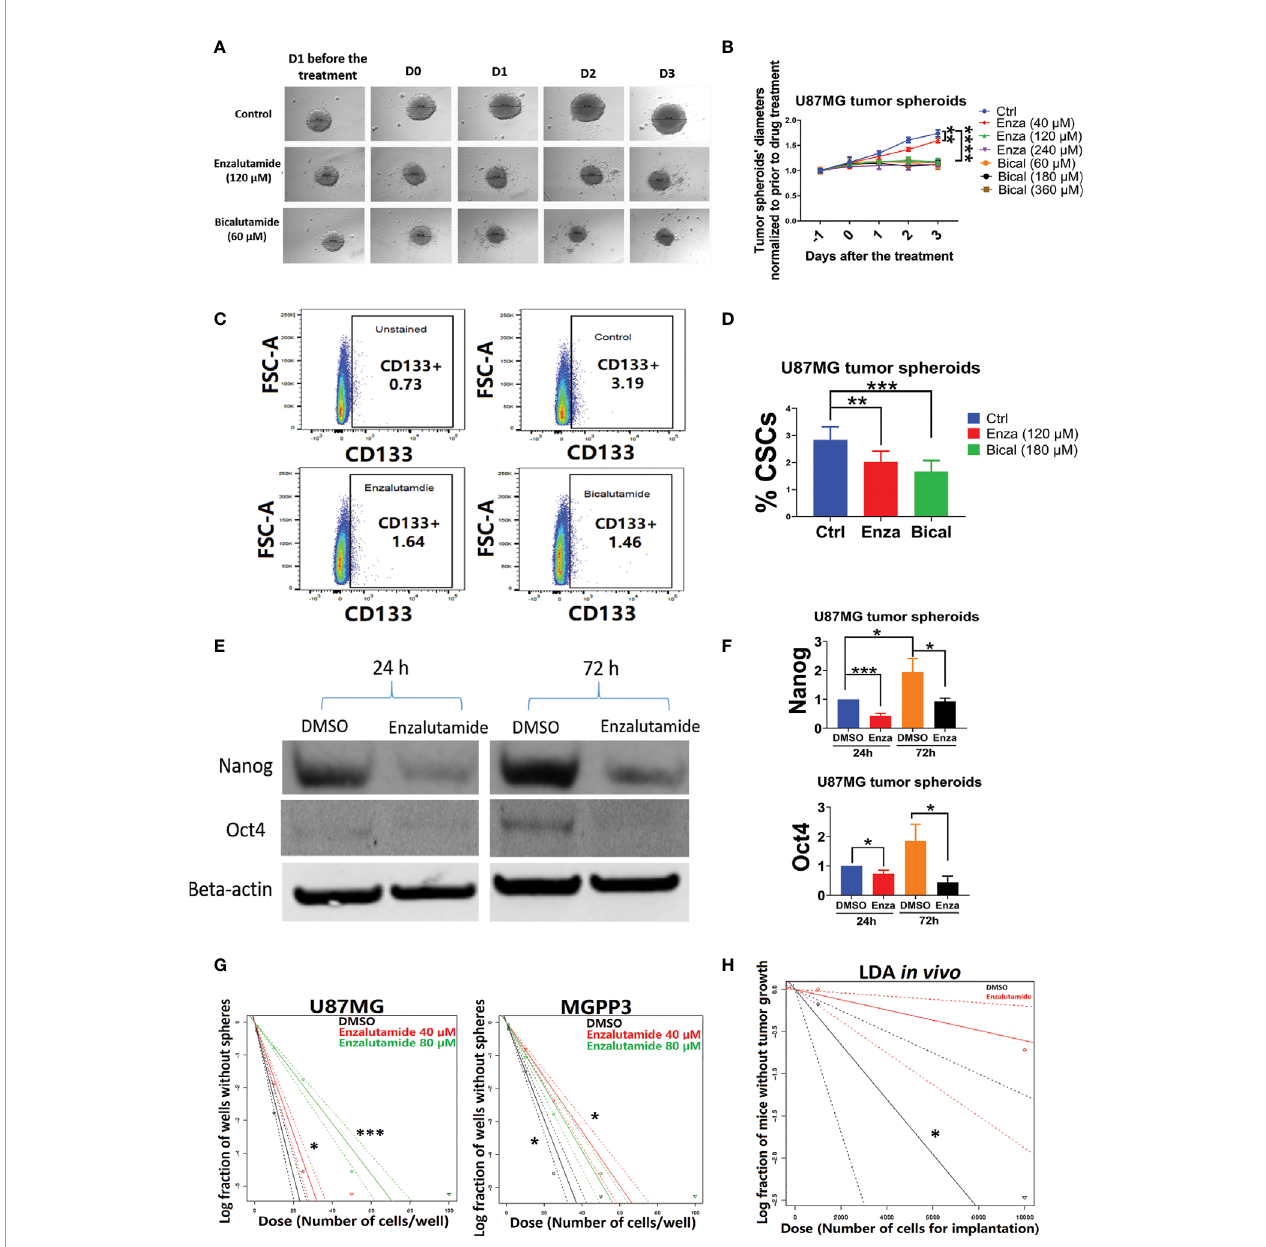
FIGURE 4 | AR antagonists decrease the cancer stem cell population in U87MG GBM cells in vitro . U87MG spheroids were cultured in low serum medium (0.5%) for 2 days and then treated with DMSO (negative control), enzalutamide (120 µM), or bicalutamide (180 µM) for another 4 days with diameters of spheroids measured daily. (A) Representative fi gures of the U87MG spheroids before and after the treatment of enzalutamide (120 µM) or bicalutamide (60 µM). (B) Measured diameters of the spheroids normalized to before the treatment during drug treatment with increasing concentrations of enzalutamide (40, 120, and 240 µM) or bicalutamide (60, 180, and 360 µM). (C) Representative fl ow cytometry gating strategy with dissociated cells from U87MG spheroids. Upper left: no drug treatment and no CD133 antibody staining; upper right: DMSO only (no drug treatment control); lower left: enzalutamide (120 µM); lower right: bicalutamide (180 µM). (D) CSC populations (CD133+) were compared in dissociated cells from spheroids with or without treatment of AR antagonists using fl ow cytometry as shown in (C) Eight replicates per group were used for fl ow cytometry with mean values presented in the histogram. (E) Western blotting assays showed decreased expression levels of CSC markers, Nanog and Oct4, after enzalutamide treatment for 24 and 72 h. (F) Quanti fi cation of Nanog and Oct4 protein levels before and after the treatment of enzalutamide for 24 and 72 h. All experiments were performed with three independent replicates. (G) Extreme Limiting Dilution Assays (ELDA) in vitro to estimate the frequency of tumor sphere-forming stem-like cells in U87MG and MGPP3 cell lines. Plot of the log (e) fraction of wells without tumor spheres as a function of plated U87MG/MGPP3 cell number/well. The more vertical the line, the higher the percentage of tumor sphere-forming cells or CSCs. (H) Extreme Limiting Dilution Assays (ELDA) in vivo to estimate the frequency of CSCs. Plot of the log (e) fraction of mice without tumor growth as a function of implanted MGPP3 cells. *p < 0.05; **p < 0.01; ***p < 0.001; ****p <